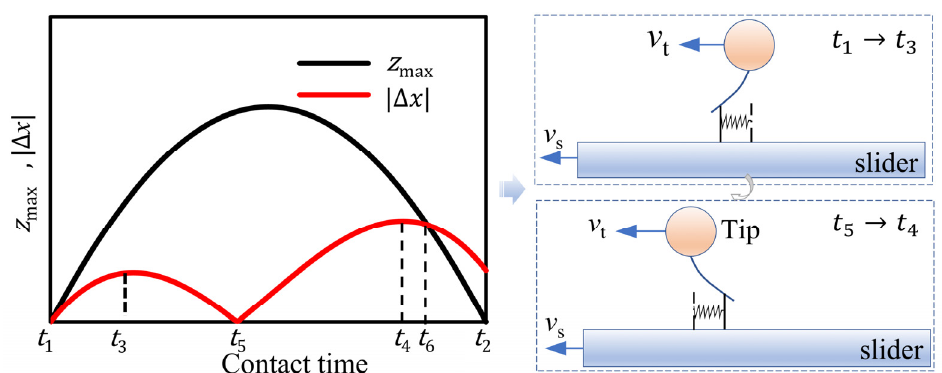
Figure 7. Deflection of the micro spring in a contact period and two typical